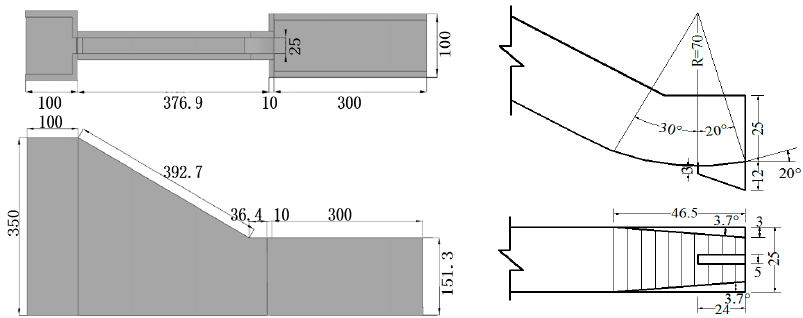
Figure 1. Geometrical configuration of the model flip bucket with dovetail slit (units: cm).